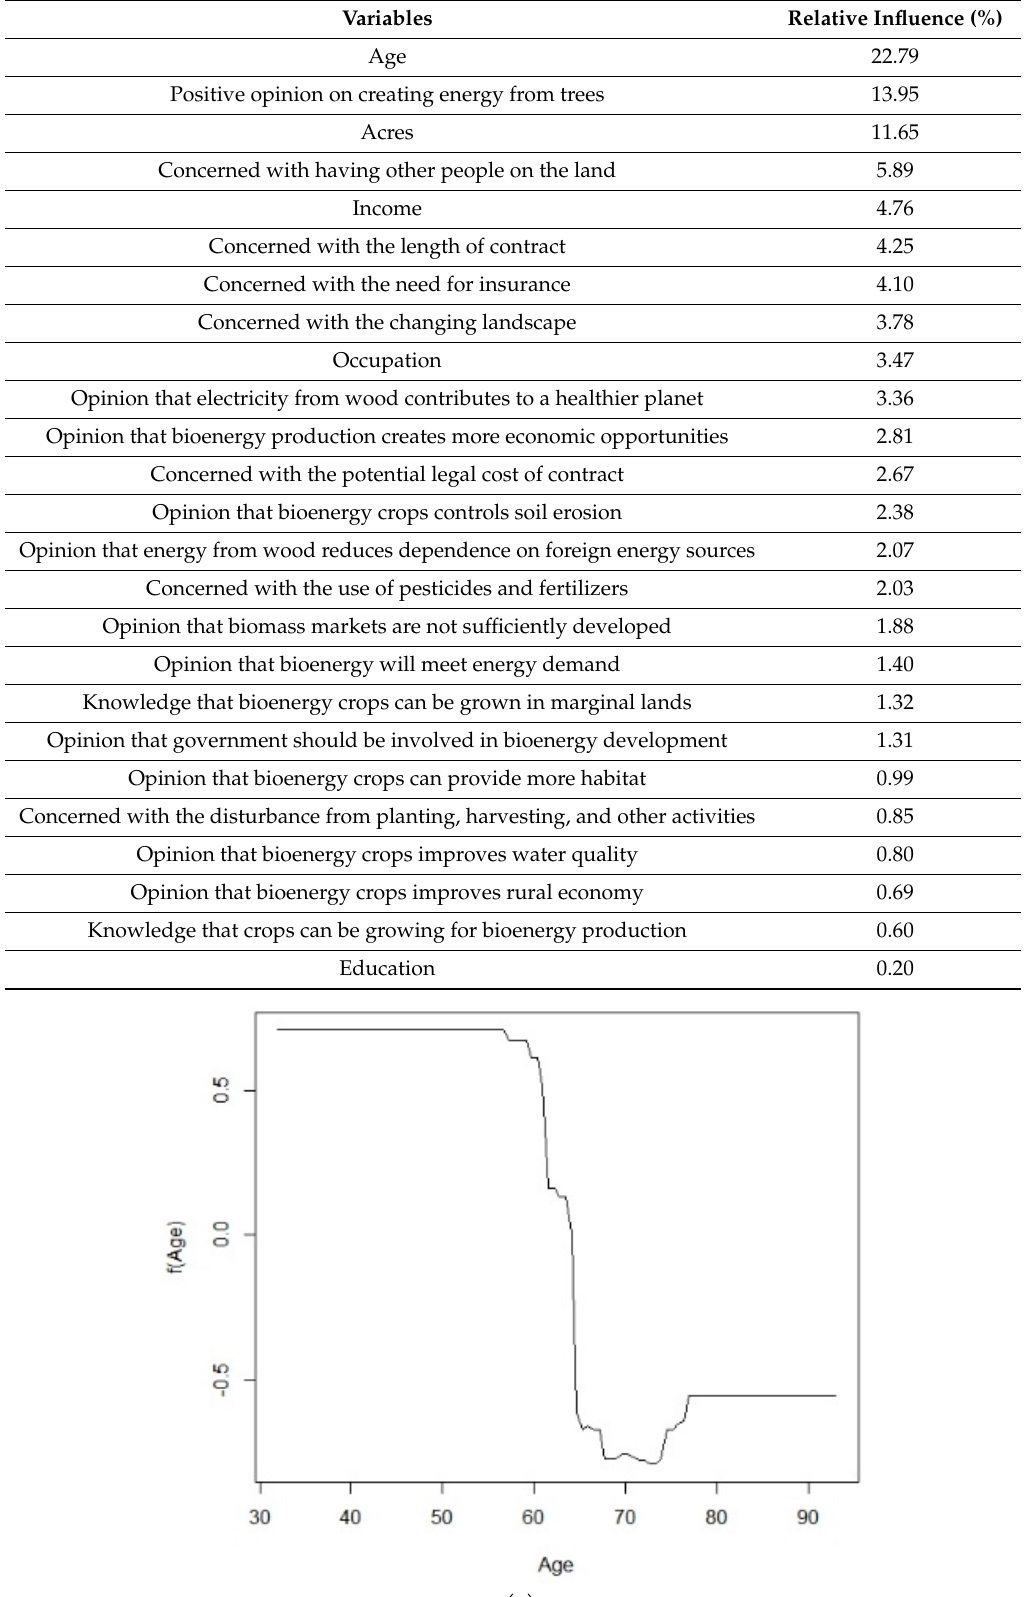
Table 6. Variables and their relative influence on landowners’ willingness to rent.